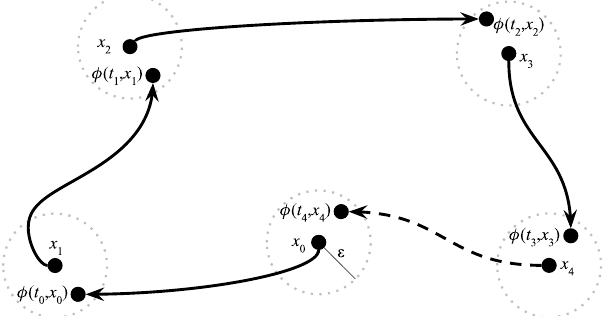
to x with respect to flow ϕ is exemplified 0 4 . If the recurrent behavior associated with point 0 1 2 3 4